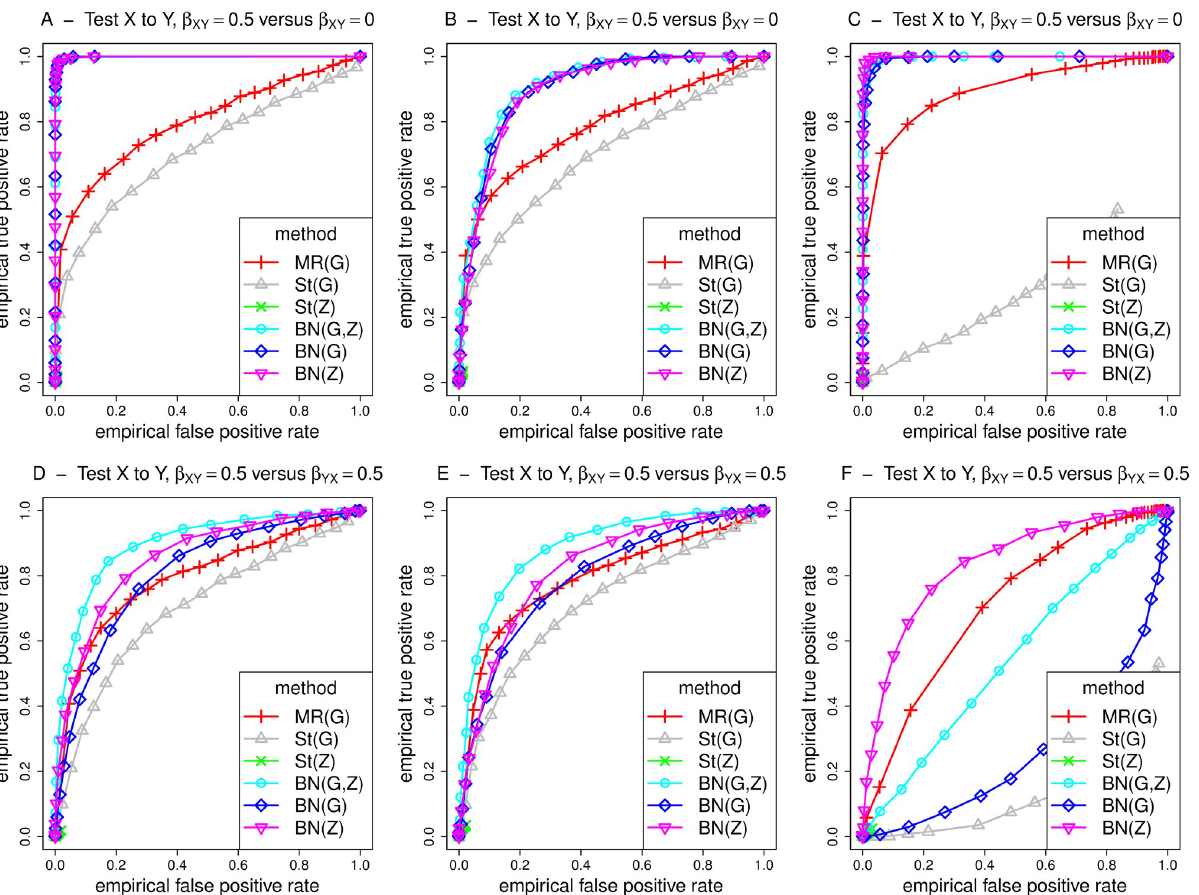
Fig 5. ROC curves for different methods for detecting an edge from X to Y, under different generating scenarios that include weak confounding. MR and St denote MR and MR Steiger respectively, performed using instrumental variable regression which takes into account the uncertainty of the predicted values in the first-stage regression to calculate the MR p -values. Left hand plots (A, D) are generated under model 1 (no confounding), middle plots (B, E) are generated under model 2 (non-genetic confounding), and right hand plots (C, F) are generated under model 3 (genetic confounding). For the top plots (panels A-C), false positives on the x-axis are counted using simulations when there is no effect ( β XY = 0), while for the bottom plots (panels D-F), the false positive rate is calculated by simulating from a model where there is a causal effect from Y to X.